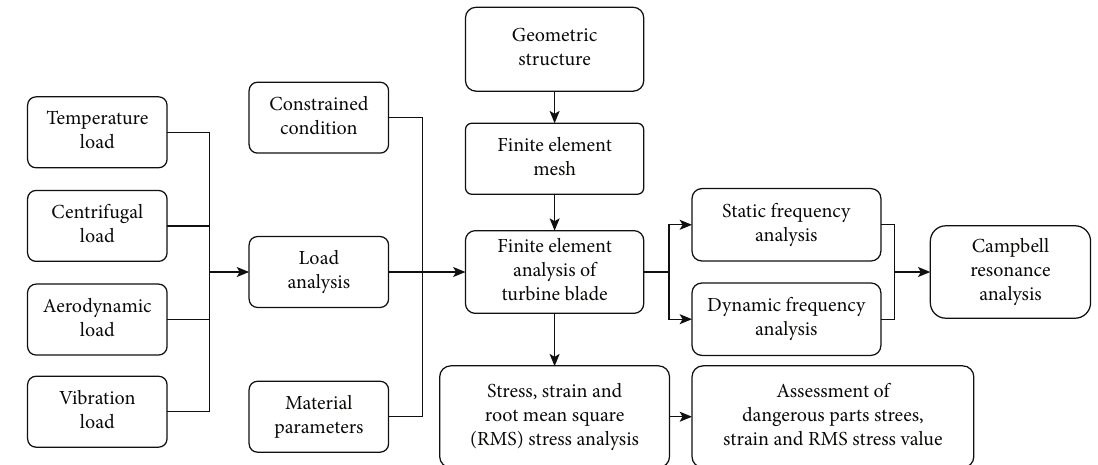
Figure 1: Flowchart of fi nite element analysis of blade.